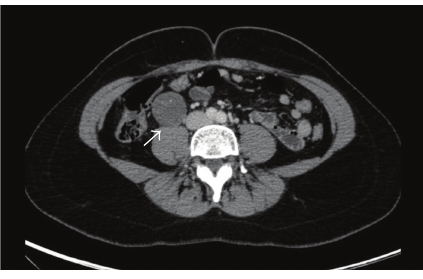
Figure 1: Axial CT image demonstrated an incidental retroperi- toneal mass on the right side with minimal heterogenous contrast enhancement.